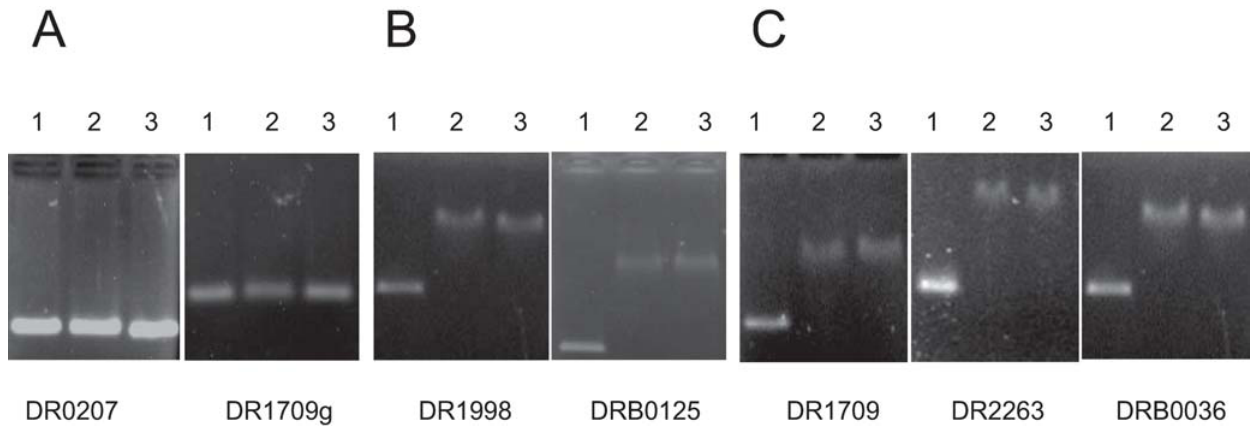
Figure 6. Binding of reduced and oxidized OxyR to the upstream region of (A) negative control ( dr0207 and coding sequence for dr1709 ); (B) positivly regulated genes ( dr1998 and drB0125 ); (C) negativly regulated genes ( dr1709 , dr2263 , and drB0036 ). To generate reduced protein, 200 mM DTT was added to the binding reactions. Column 1, 2, and 3 indicate non-added protein, reduced OxyR added, and oxidized OxyR added, respectively.